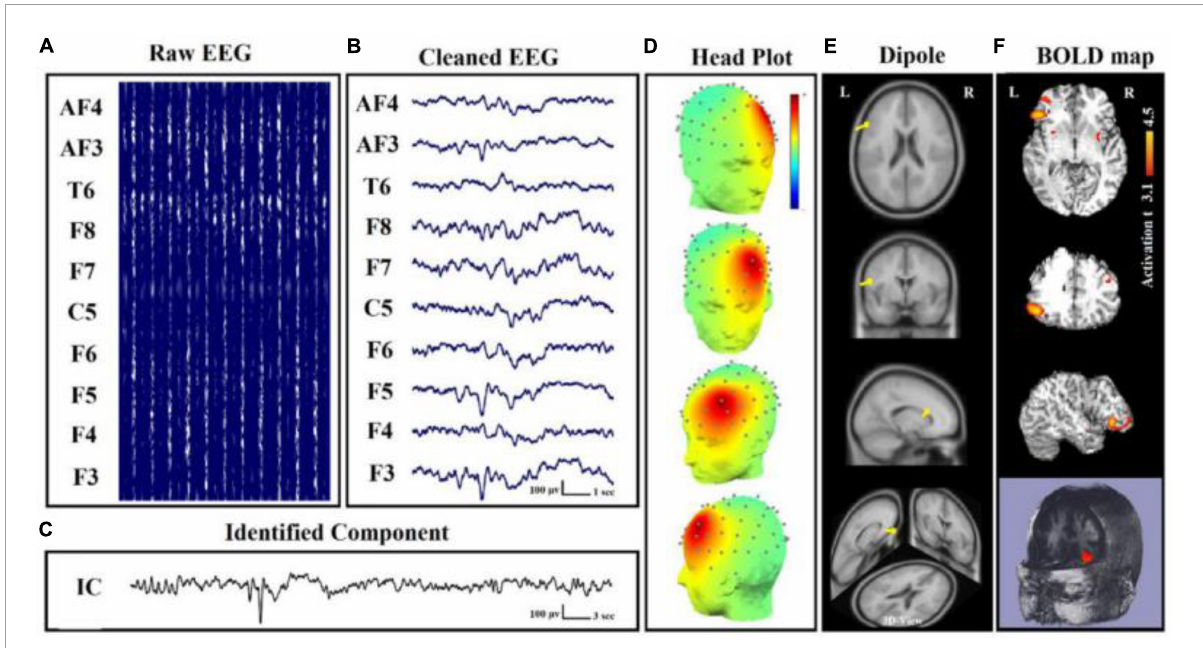
FIGURE8 Simultaneous EEG-fMRI analysis on a patient with focal epilepsy in order to localize the seizure onset zone (SOZ). (A) Simultaneously recorded raw EEG data. (B) The EEG data after artifact removal. (C) The epilepsy-related component time series obtained using Independent Component Analysis (ICA) algorithm. (D) The 3D map of the candidate component. The active area is marked by yellow-red color. (E) The result of dipole localization of the identified generator in deep brain structures. (F) The final result of localizing the SOZ applying simultaneous analysis of EEG–fMRI (Ebrahimzadeh et al.,